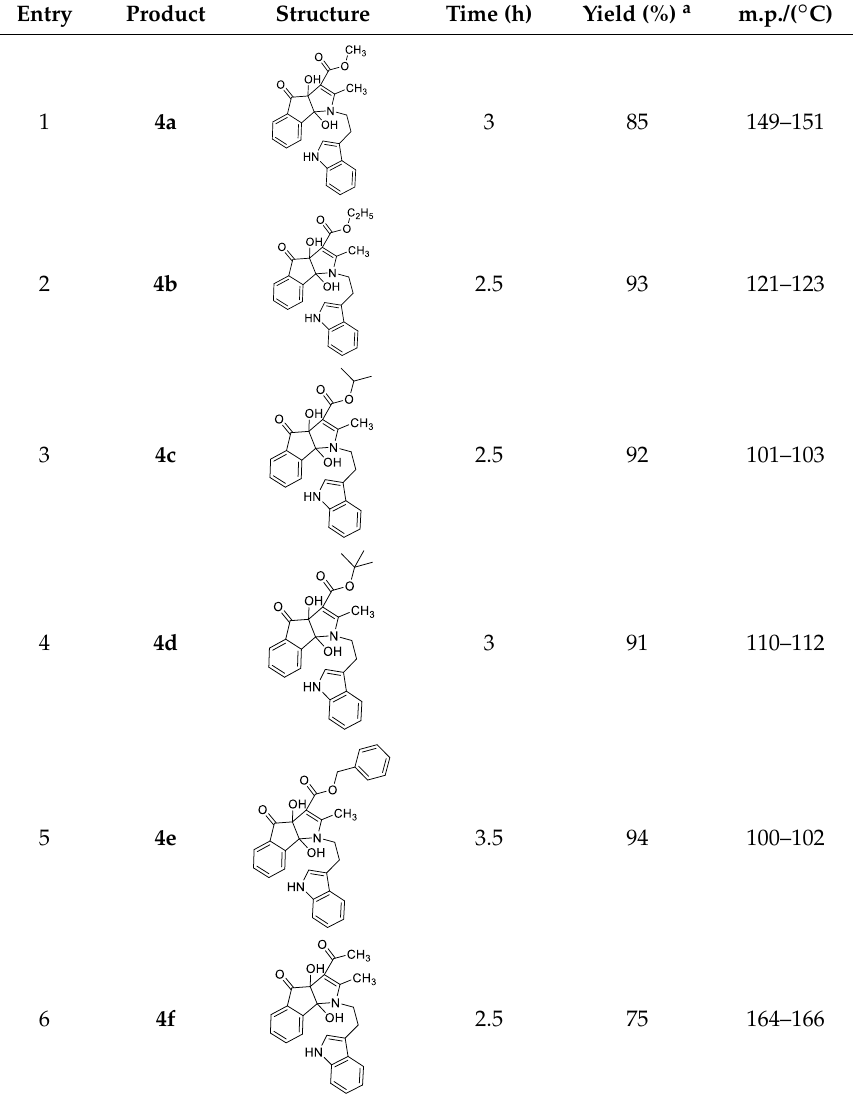
Table 2. The synthesis of compounds 4 .